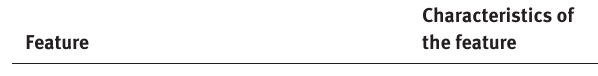
Characteristics